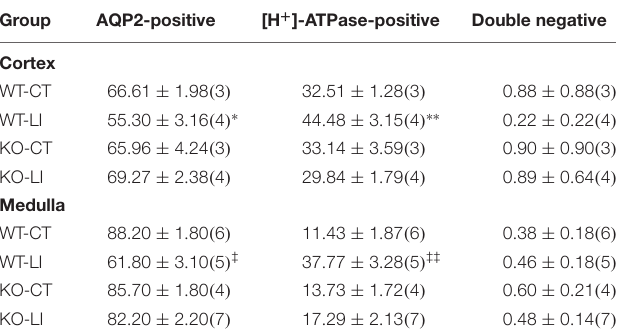
TABLE 2 | Percent distribution of AQP2-positive, [H + ]-ATPase-positive or double negative cells in the cortical and medullary collecting ducts of WT or P2Y 2 KO mice fed control or lithium-added diets for 5